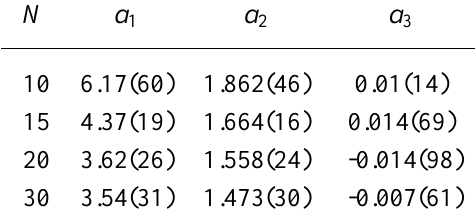
Table 4: Partition function zeros corresponding to the two transitions observed for Ala